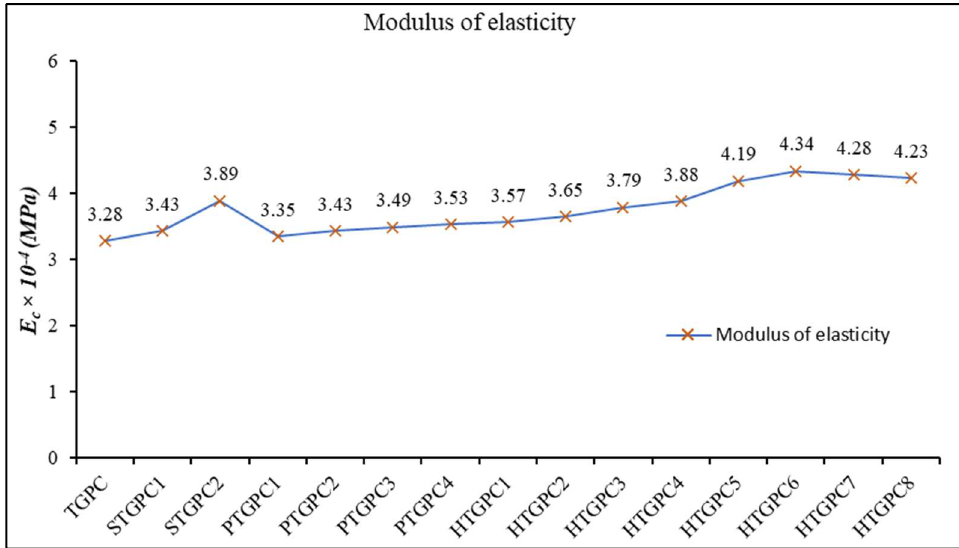
Figure 9. Comparison of modulus of elasticity.